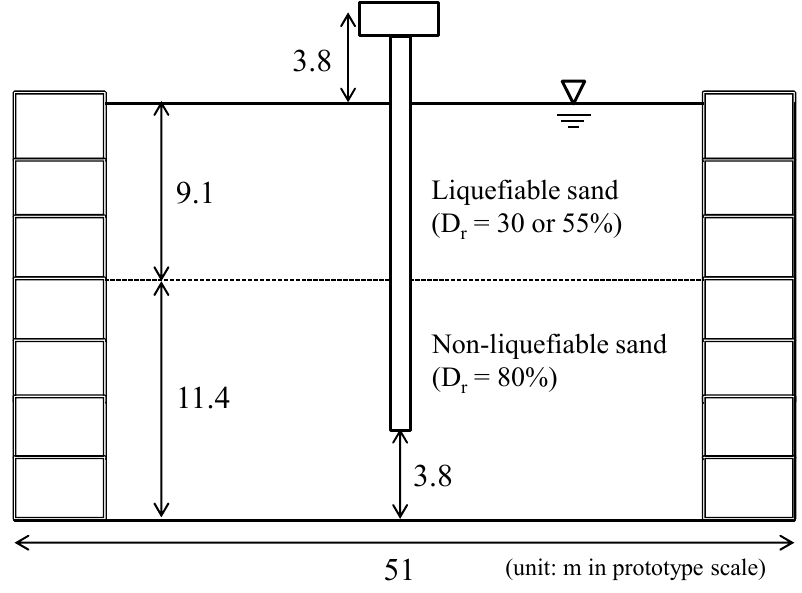
Figure 7. Layout of the experimental model (Wilson, 1998 [16]).